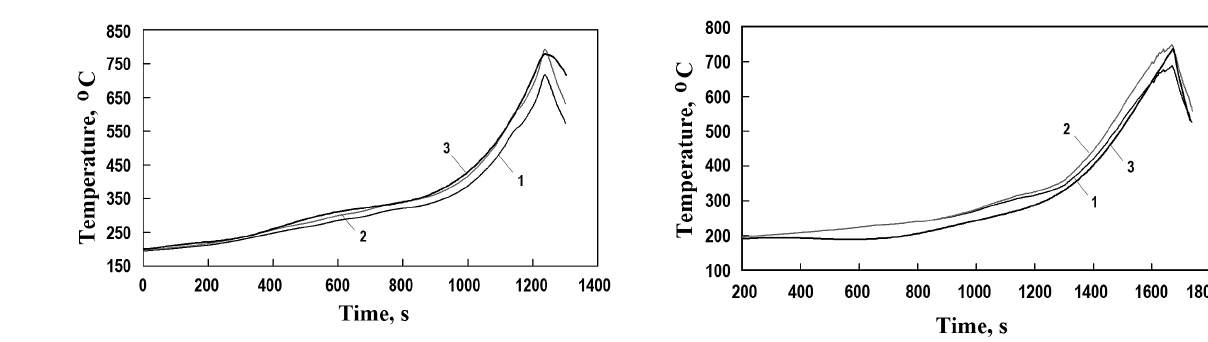
Figure 5. Time-temperature curve for experiment 2: TET read- ings (1); cladding temperature values determined using the TET readings with corrections taken into account (2); calculated cladding temperature values (3)